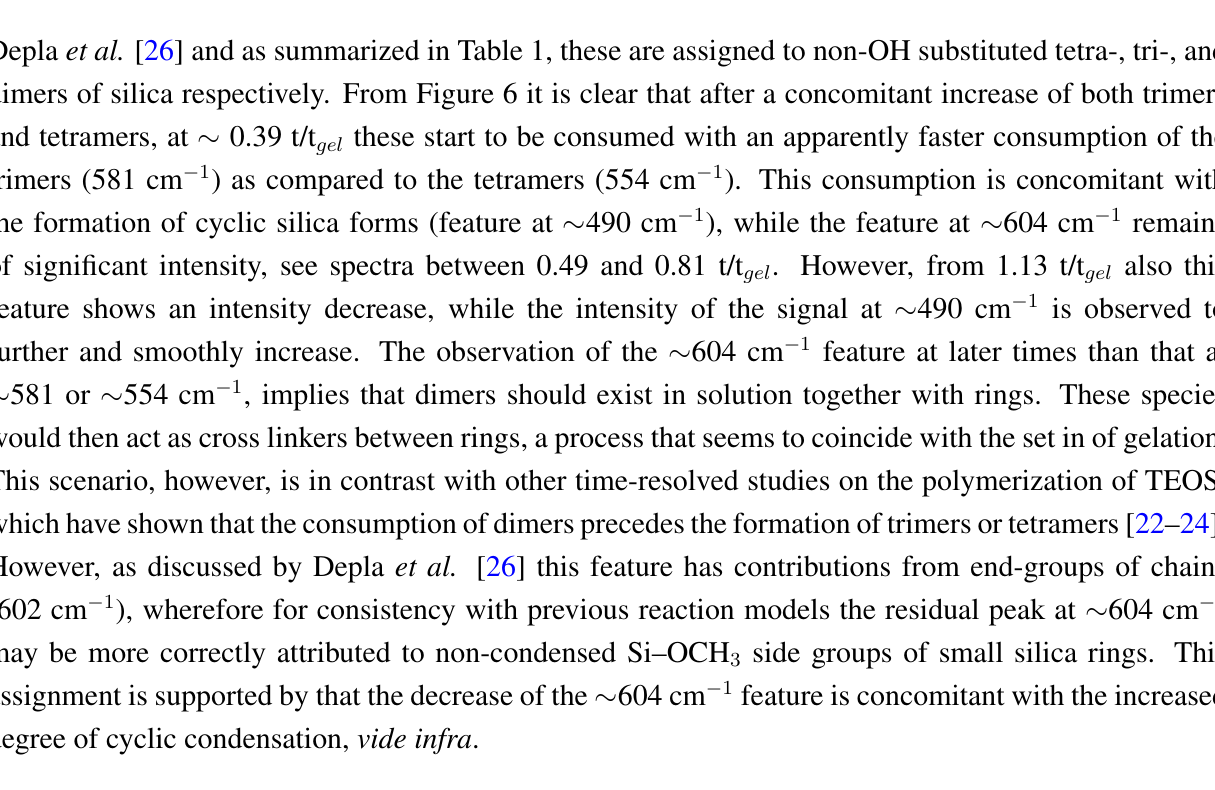
Figure 6. Close-up of the spectral range 400–1000 cm − 1 showing spectra recorded in the time domain 0.17–1.35 t/t , for the solution with no ionic liquid added. Spectral signatures gel assigned to cyclic (green) and linear (yellow) species are indicated by dashed